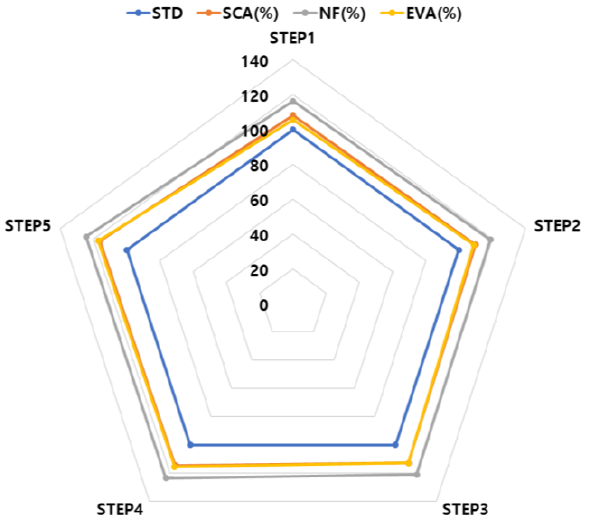
Figure 12. Increase/decrease rate of solid content according to the input amount of each additive.